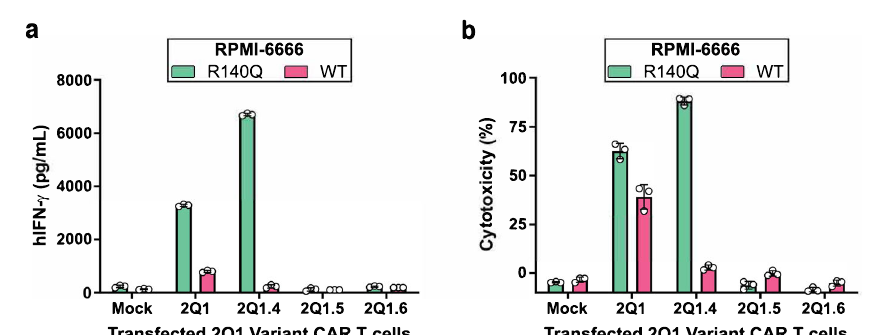
Fig. 5 Structure-guided optimization of the 2Q1 clone. a Binding of 2Q1 and its variant scFvs to IDH2 R140Q or IDH2 WT pHLA monomers was assessed by ELISA. Data represent the mean of three technical replicates ± SD. Supplementary Fig. 9 includes details about the distribution of the data. b Binding of 2Q1 and its variant IgG1s to IDH2 R140Q or IDH2 WT pHLA monomers was assessed by ELISA. Data represent the mean of three technical replicates± SD. Supplementary Fig. 9 includes details about the distribution of the data. c , d RPMI-6666 cells were loaded with peptide variants from a positional-scanning library and stained with either ( c ) 2Q1 IgG1 or ( d ) 2Q1.4 IgG1. Binding was evaluated by fl ow cytometry with the gating strategy depicted in Supplementary Fig. 10. Heat maps, on left, were generated from the median fl uorescence intensity (MFI). Orange boxes represent the residues in the IDH2 R140Q target peptide. Illustrations, on right, of the binding pattern of each respective IgG1 represented as sequence logos. The tallest columns correspond to the positions with the greatest speci fi city and the red arrows denote the position of the IDH2 140 residue. e 2Q1.4-Fab binding to IDH2 WT -HLA-B*07:02 was measured by multi-cycle kinetics using SPR with increasing concentrations (6.25, 12.5, 25, 50, 100, 200, 400, 800 nM) of puri fi ed 2Q1.4-Fab ( N = 2). The curves were fi t with a 1:1 binding model to calculate the listed K D . NB, no binding. f Same as ( e ) using IDH2 R140Q -HLA-B*07:02. Source data are provided as a Source data fi le.